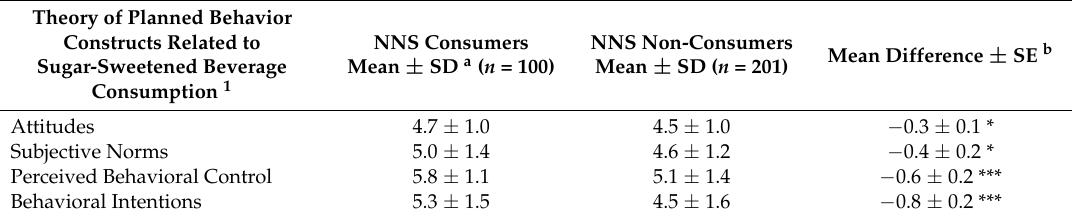
Table 7. Theory of Planned Behavior constructs regarding sugar-sweetened beverage intake for non-nutritive sweetener (NNS) consumers versus NNS